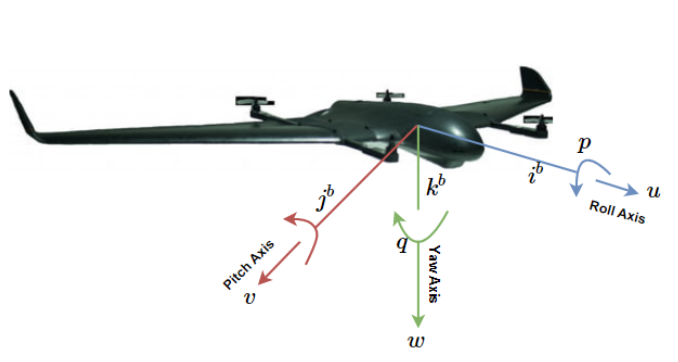
Figure 11. Body frame in a fixed-wing